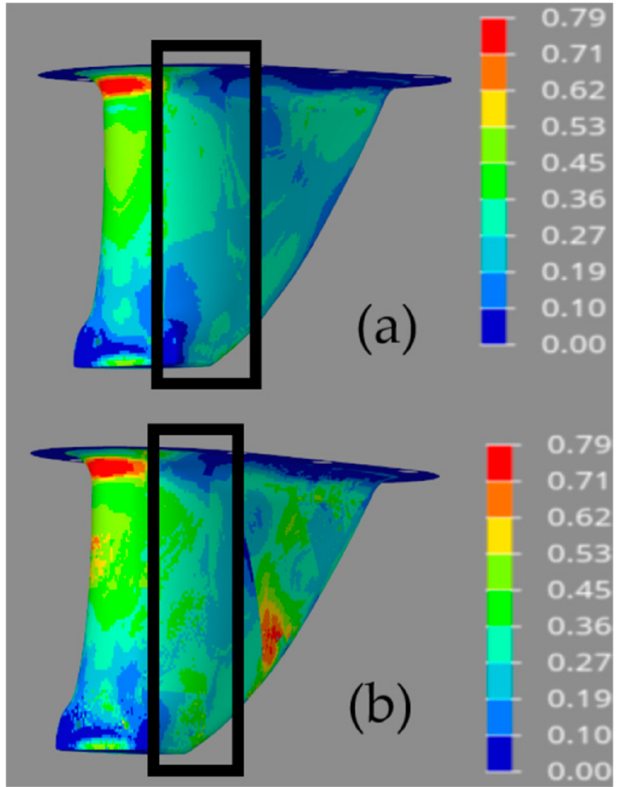
Figure 15. Maximum Stress failure criteria values in the finger joint area for the partitioned no drape ( a ) and partitioned draped models ( b ) following topology